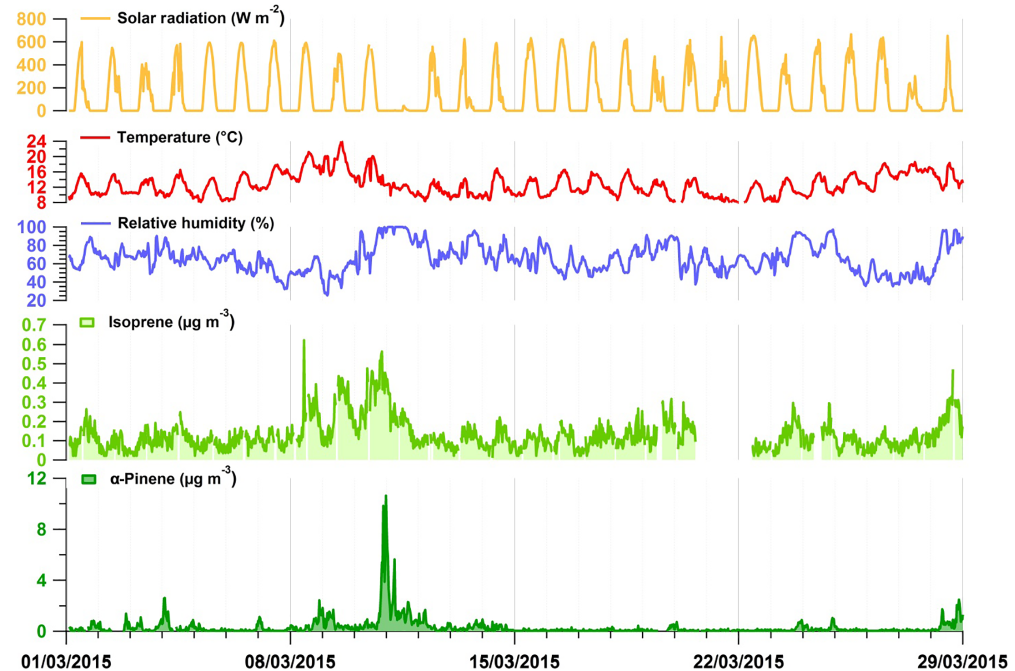
Figure 5. Time series of a selection of biogenic VOCs (isoprene and α -pinene – green lines) in comparison with meteorological parameters (solar radiation, temperature and relative humidity; displayed as orange, red and blue lines,